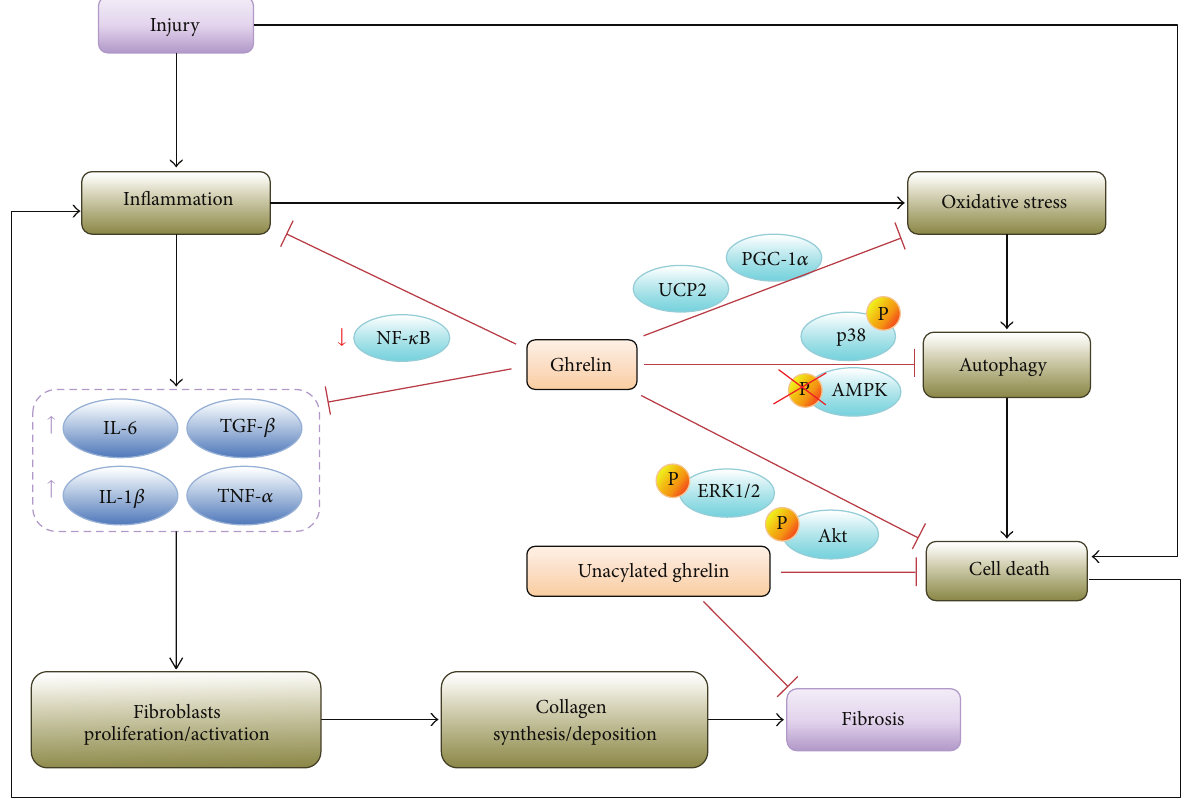
Figure 1: Schematic representation of the molecular pathways involved in the antifibrotic activity of ghrelin and unacylated ghrelin. See text for